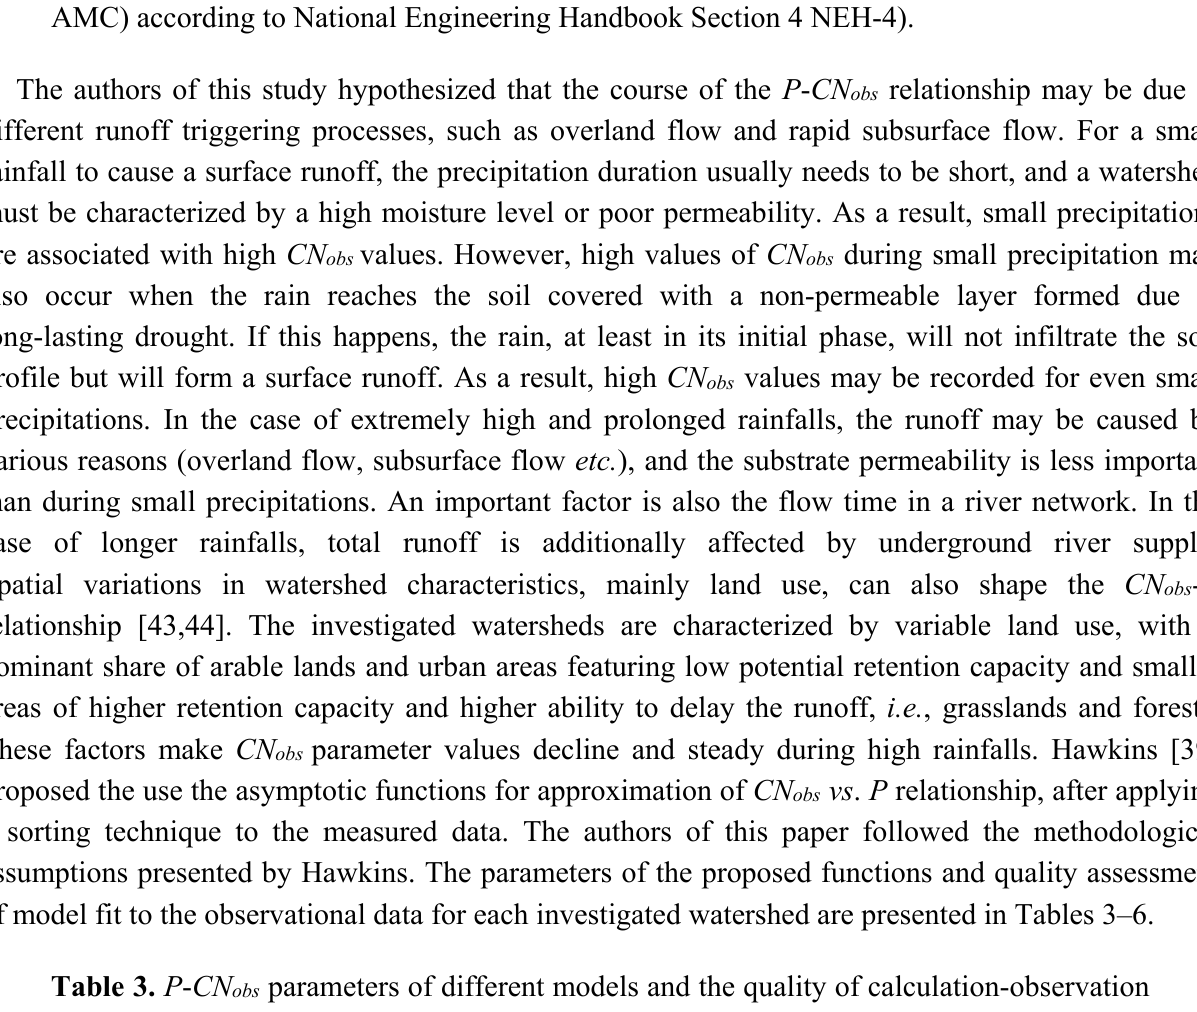
Figure 3. The relationship of the observed CN ( CN obs ) and precipitation P (dots), with approximation of asymptotic functions CN(P) by Equations (6) to (8); dashed horizontal lines represent CN emp values for selected moisture levels (antecedent moisture conditions, AMC) according to National Engineering Handbook Section 4 NEH-4).